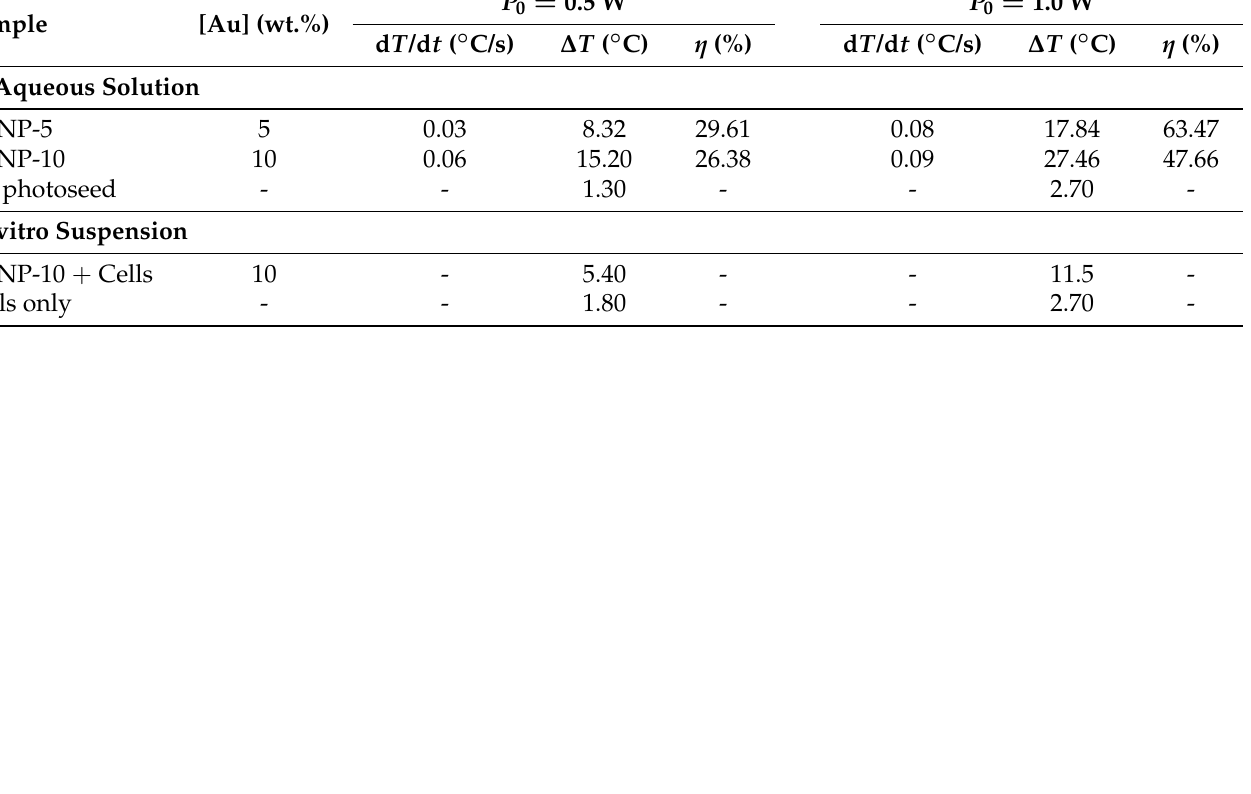
Table 3. A summary of the results from photothermal measurements expressed as the mean values of initial ( t = 30 s) heating rate, d T /d t , temperature change, ∆ T , calculated as the difference between the initial ( t = 0 min) and final ( t = 5 min) temperatures and η , photothermal conversion efficiency, calculated while using Equation (1).